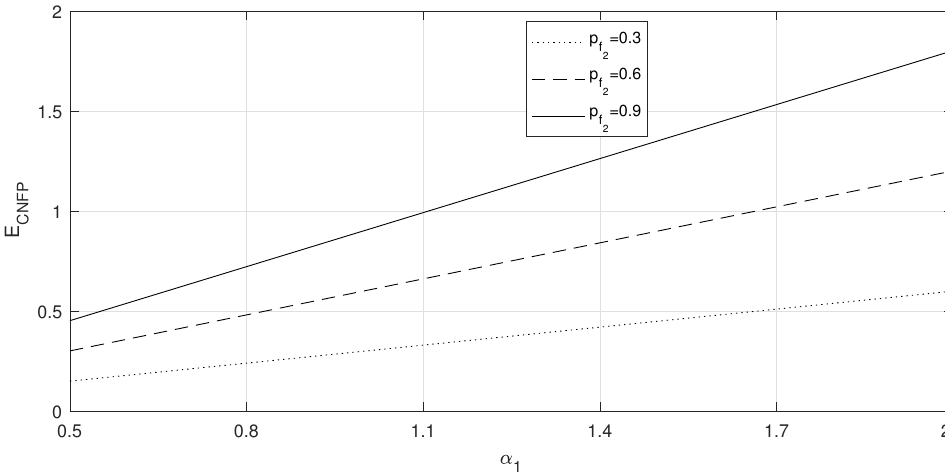
vs. α 1 . 1 on the E RP , E CQ 1 , E COSRP , , q r , andq r 2 3 1